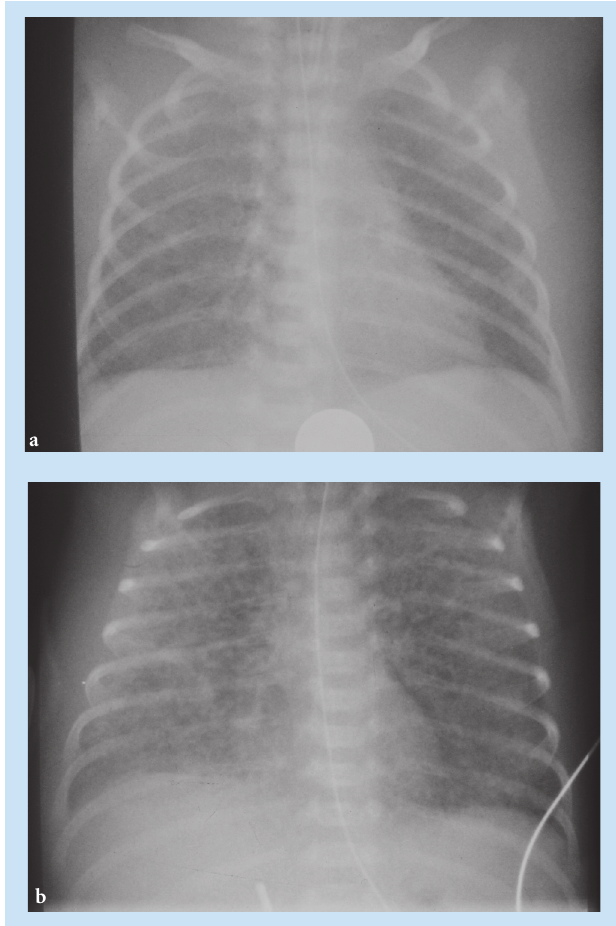
pattern.Fig. 11. Complications of ventilation. (a) Bilateral symmetrical airspace disease consistent with hyaline mem- brane disease requiring ventilation. (b) The same patient as in Fig. 11 (a) demonstrating subtle diffusely distributed oval lucent cysts compatible with early pulmonary interstitial emphysema as a result of